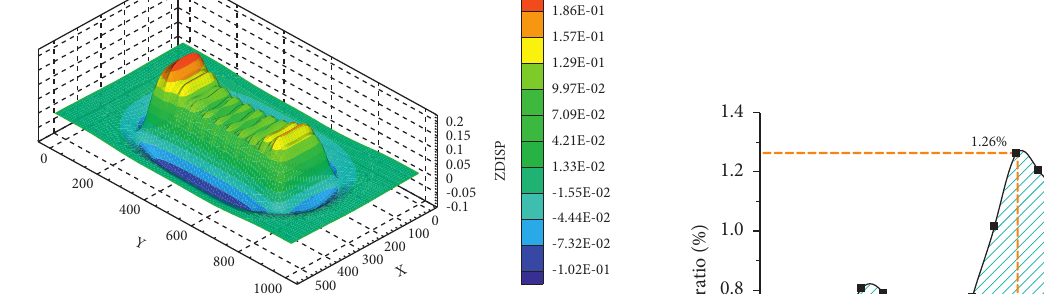
Figure 18: Change curve of protected expansion rate.